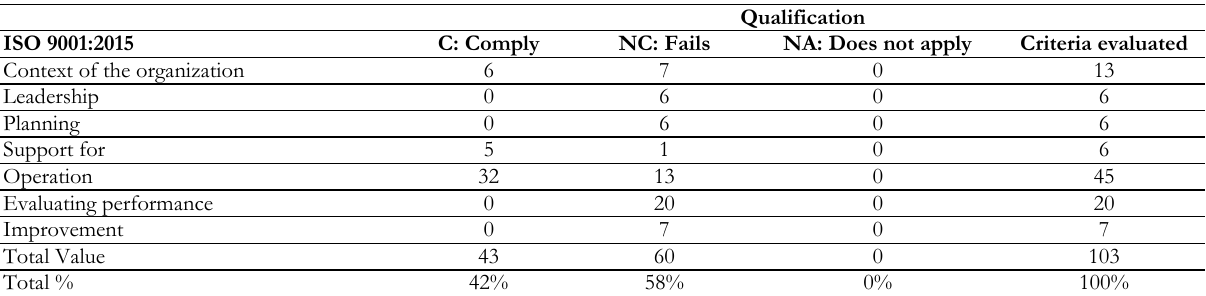
Table 6. Results of the ISO 9001:2015 evaluation